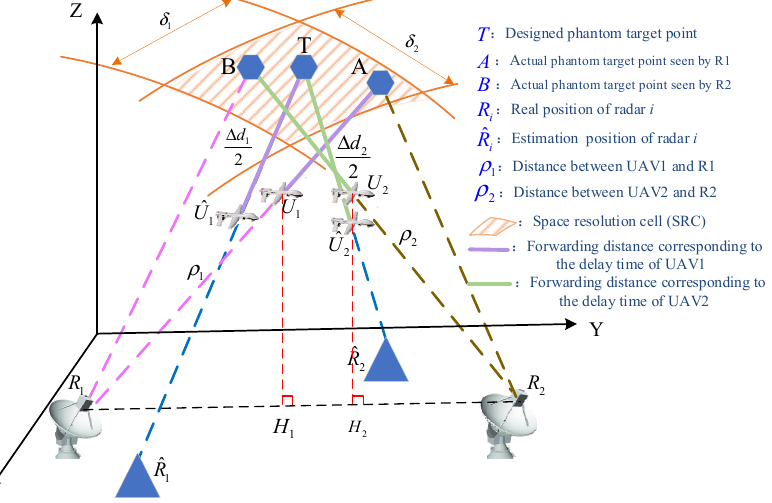
Figure 4. Same source testing of radar network using the SRC rule.